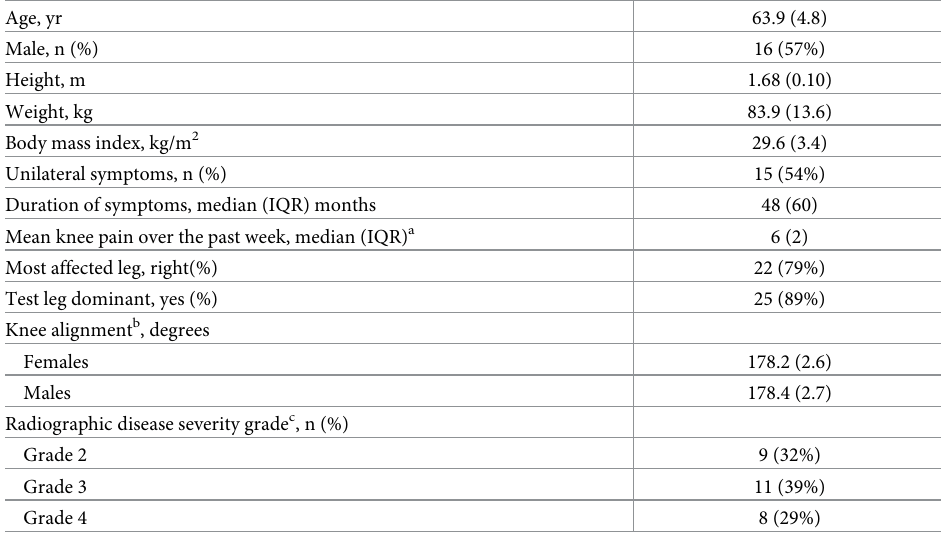
Except where indicated otherwise, values are mean (standard deviation) a Numerical rating scale (0 = no pain to 10 = worst pain possible) b Anatomic alignment, where neutral alignment is 181˚ for females and 183˚ for males and varus is < 181˚ for females and < 183˚ for males; c Kellgren-Lawrence grading system; IQR: interquartile